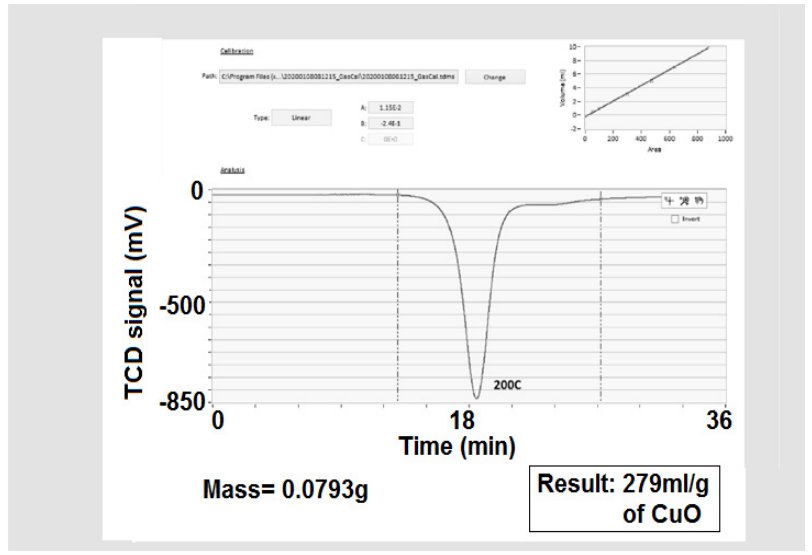
Figure 2. TPR profile on the 13% CuO catalyst.